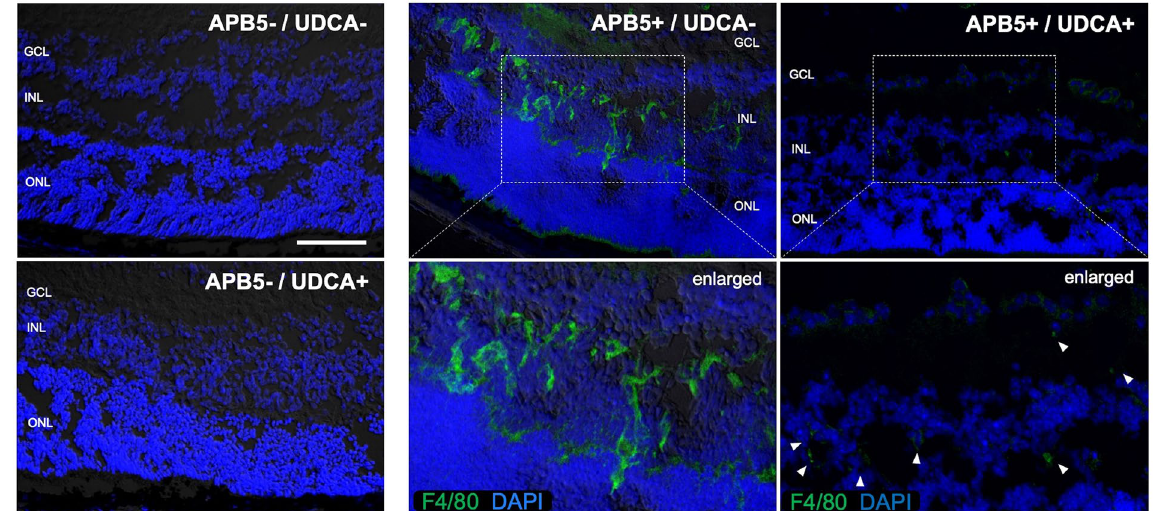
Figure 3. UDCA reduced the expression of F4/80 + macrophages in APB5-induced PC depletion mice. Immunofluorescent labeling with F4/80 (green) and DAPI (blue) is shown, and lower pictures are partial enlarged images. The number of F4/80 + macrophages decreased markedly with UDCA-treated mice in INL in the retina (white arrowhead indicate F4/80 immunofluorescent labeling). Scale bar: 100 μ m. DAPI, 4–6-diamino-2-phenylindole.